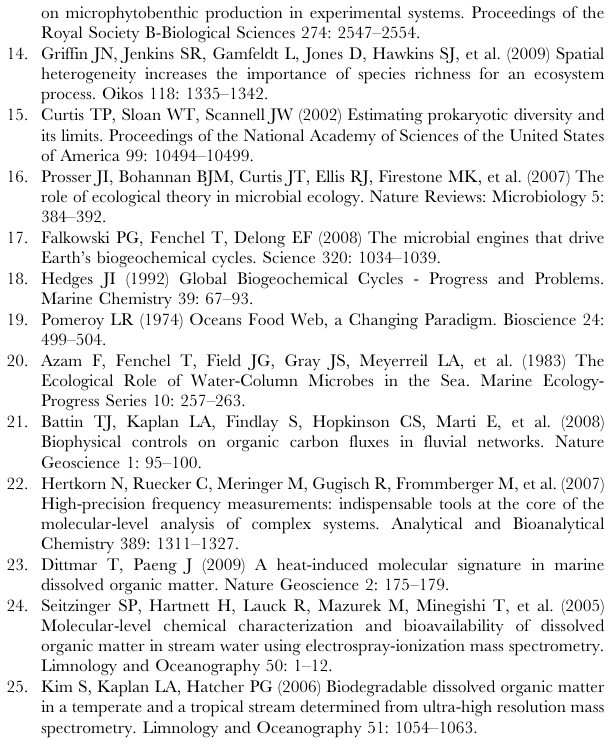
Table S4 Results of hierarchical partitioning analysis of DOC compound-specific characteristics as predictors for mass transfer to the streambed.